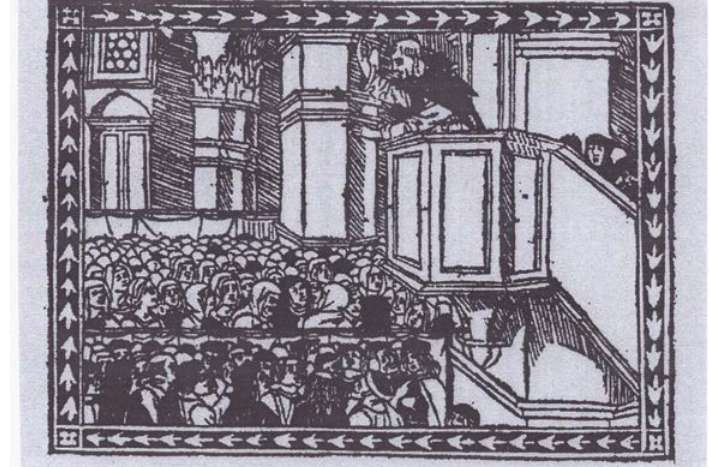
Figure 9 – Girolamo Savonarola, Compendio di rivelatione , ad instantia di ser Piero Pacini da Pescia, Firenze 23 aprile 1496, f. 1r (BNCF, Sav. 146). By permission of Ministero per i beni e le attività culturali / Biblioteca Nazionale Centrale.